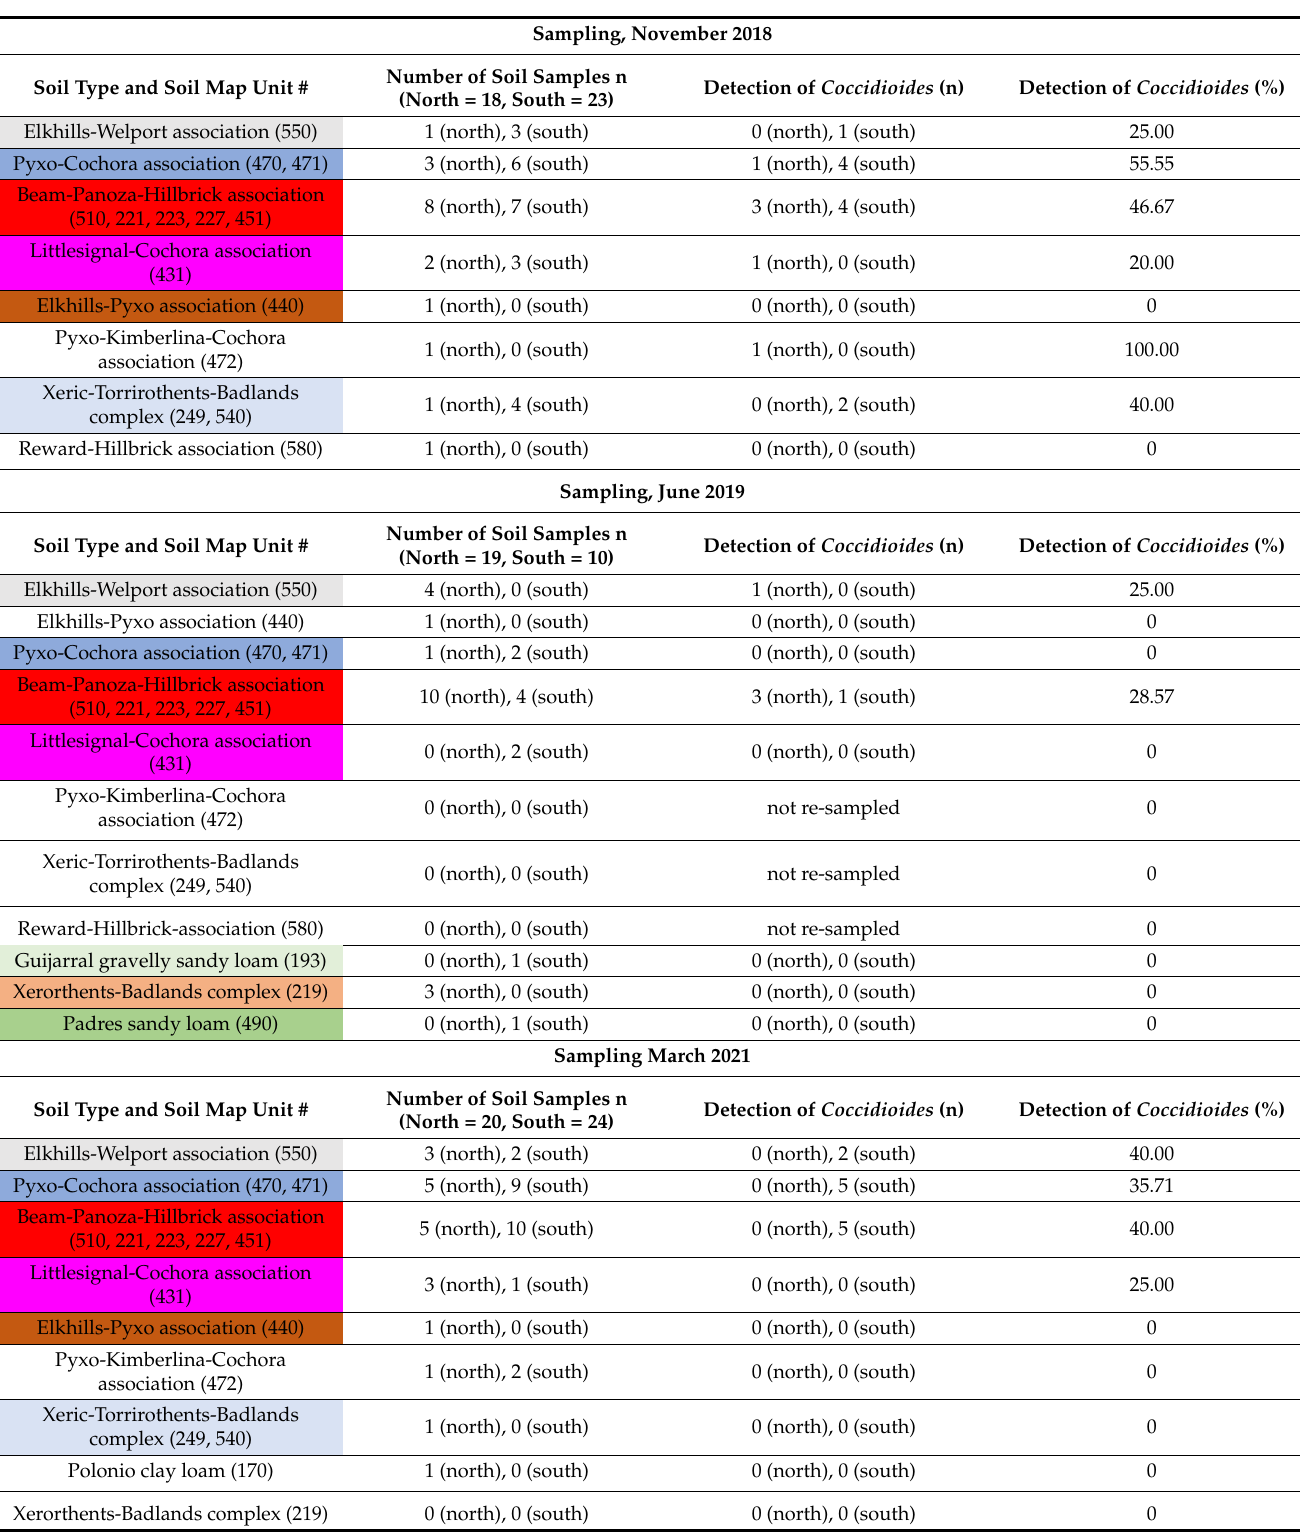
Table 1. Soil types in the Temblor SRMA that tested positive for Coccidioides . The table combines results for the southern and northern sampling areas for all three sampling events. The percentage of positive results for specific soil types is indicated. Soil types are color coded to match Figure